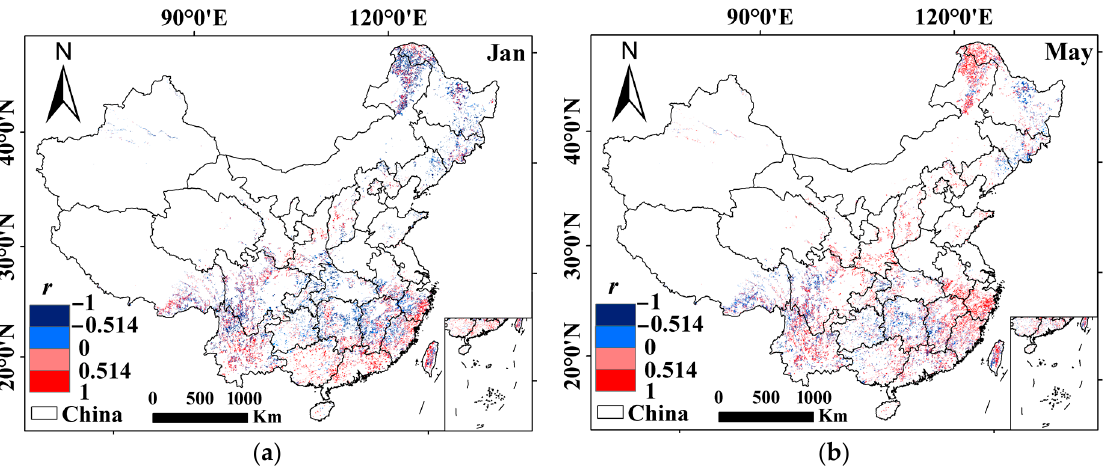
Figure 4. Spatial distribution of the strongest correlations (the r corresponds to | r | max ) of forest vigor with water availability in China: ( a ) Pregrowing season (e.g., January) and ( b ) growing season (e.g., May). The correlation significant at p < 0.05 is equivalent to | r | > 0.514 [36]. White areas indicate nonforest areas in China.